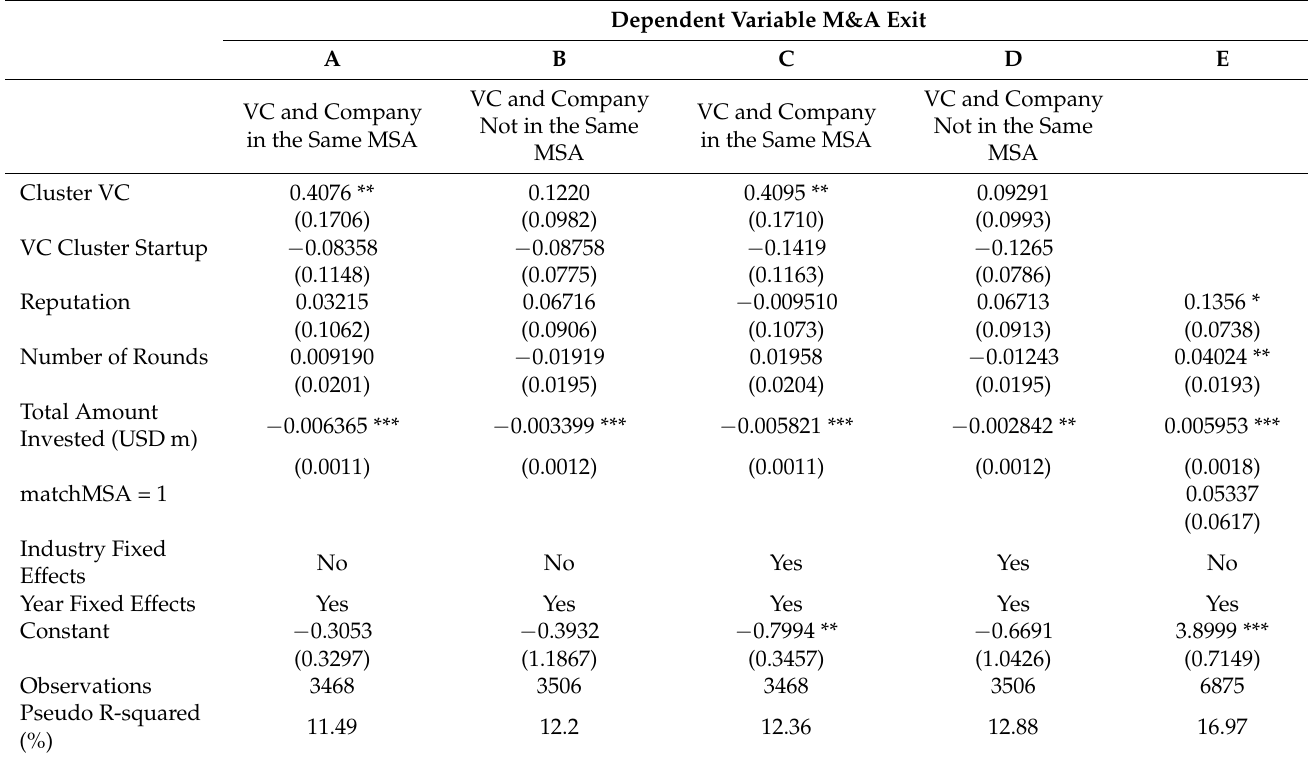
Table 6. Regression Results of Startup, Industry and VC Cluster Variables on M&A Exits while controlling for MSA